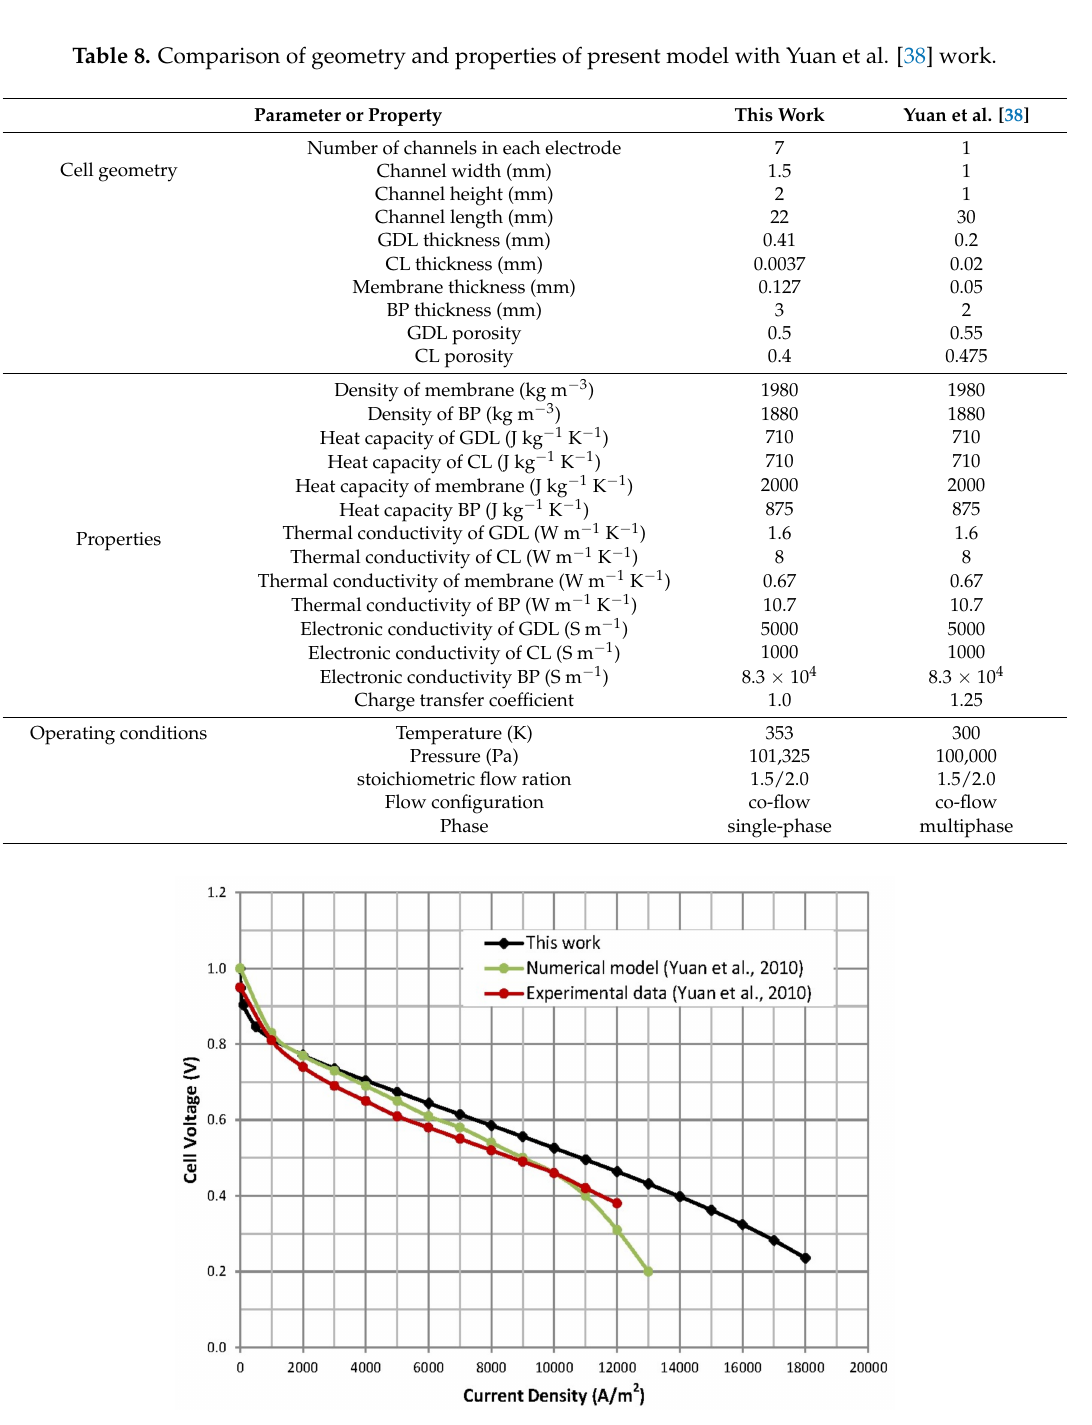
Figure 5. Cell polarization curve compared to the literature model and experimental